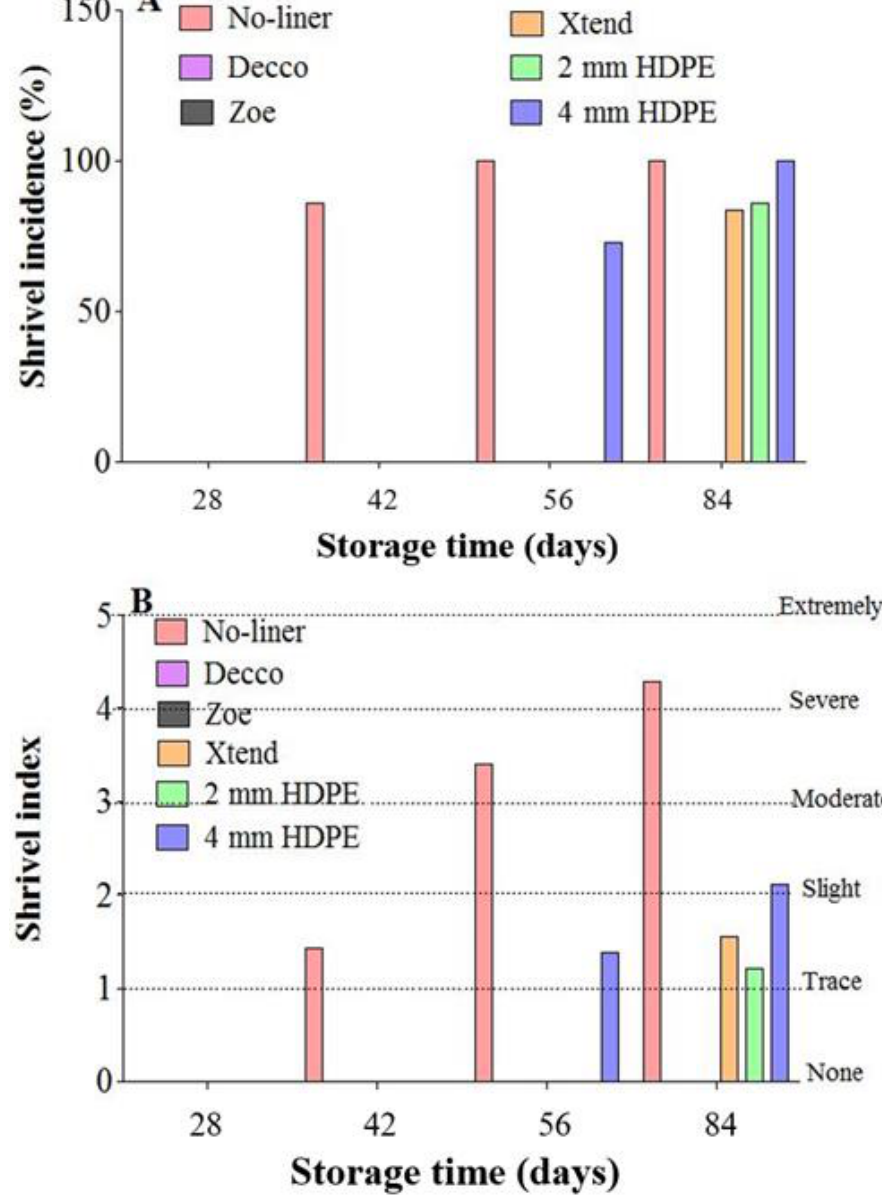
Figure 10. Percentage of total shrivelled fruit (shrivel incidence) ( A ) and shrivel index (incidence) ( B ) observed on pomegranate fruit stored for 84 d at 5 °C and 90% relative humidity (RH). HDPE: high density polyethylene.